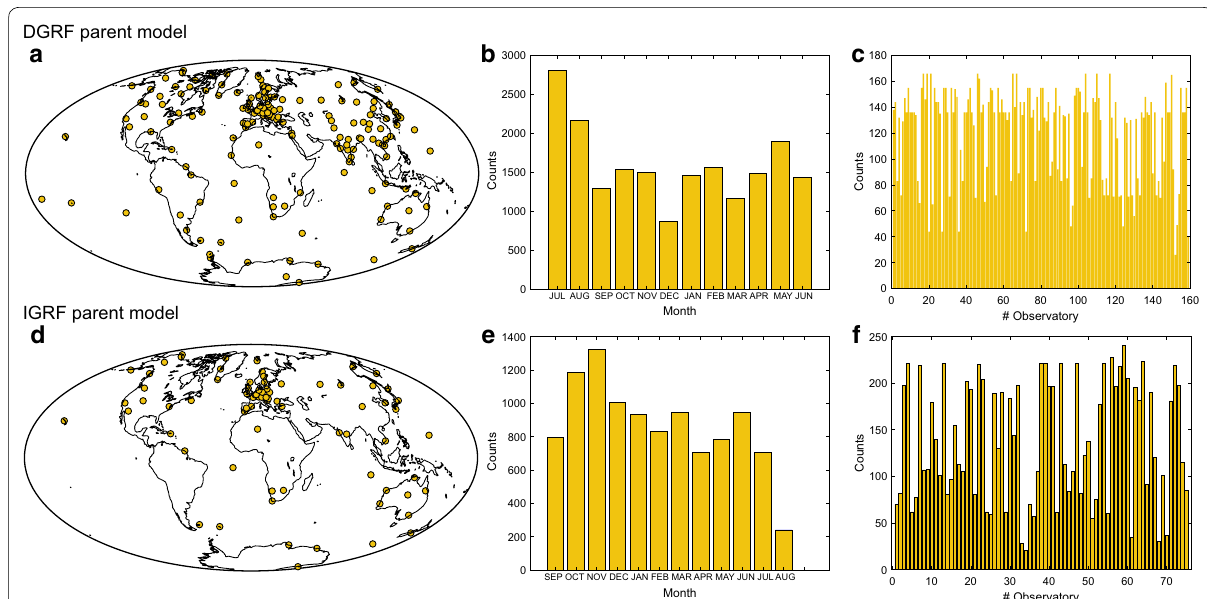
Fig. 2 a , d Spatial distributions of the observatories. b , e Number of observatory data per month (see time windows in the main text). c , f Number of data per observatory ( x ‑axis numbers correspond to the IAGA code given in Additional file 1: Table S1). Upper panel: observatories for DGRF parent model. Lower panel: observatories for IGRF parent